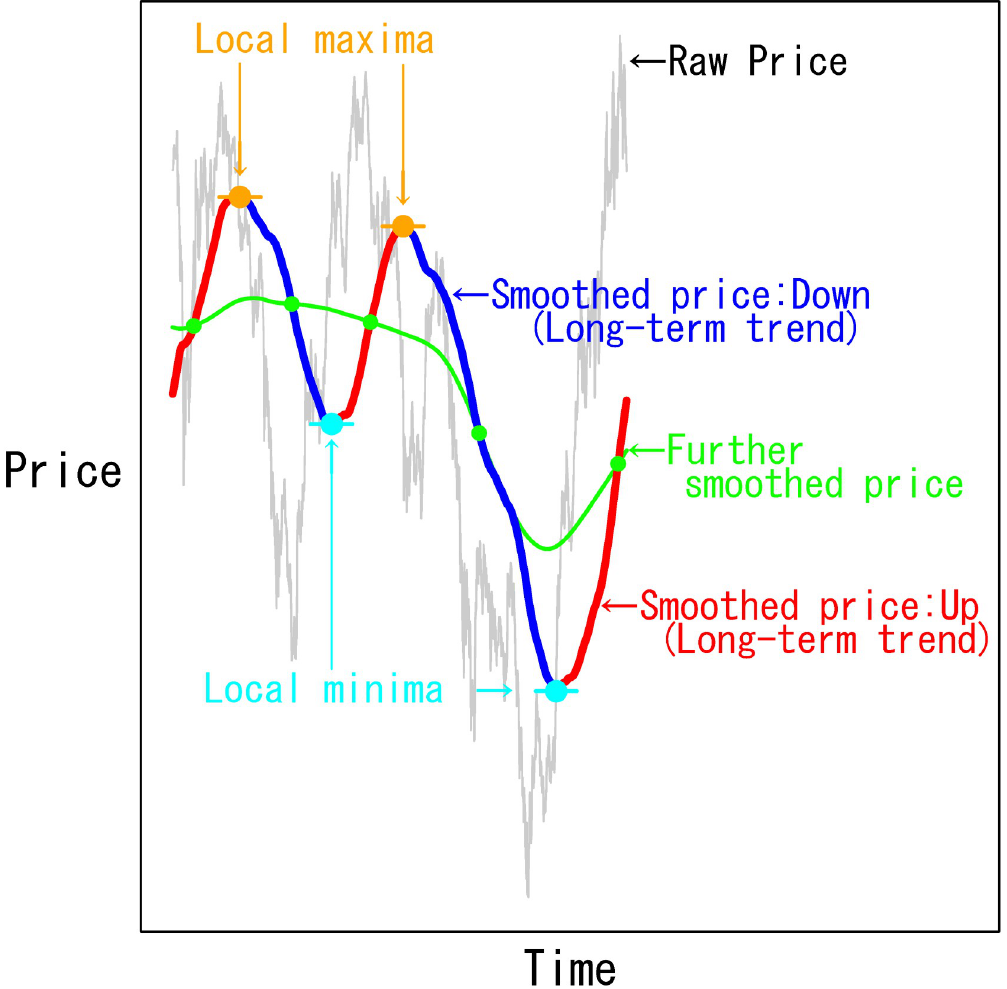
Fig 2. Algorithm to assign the smoothed price trend direction labels. Local maxima (minima) between adjacent intersections of the smoothed price trend (thick red and blue lines) and further smoothed price trend (green line) are set as the trend direction reversal points of the smoothed